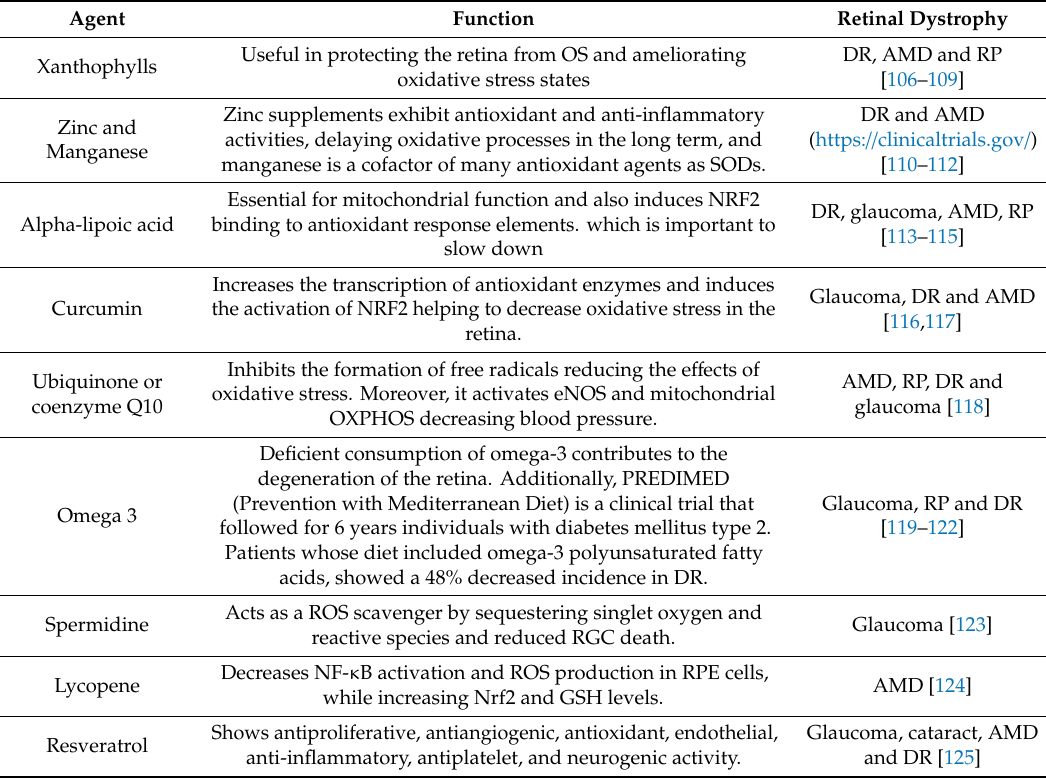
Table 1. Dietary supplementation with antioxidant compounds in retinal